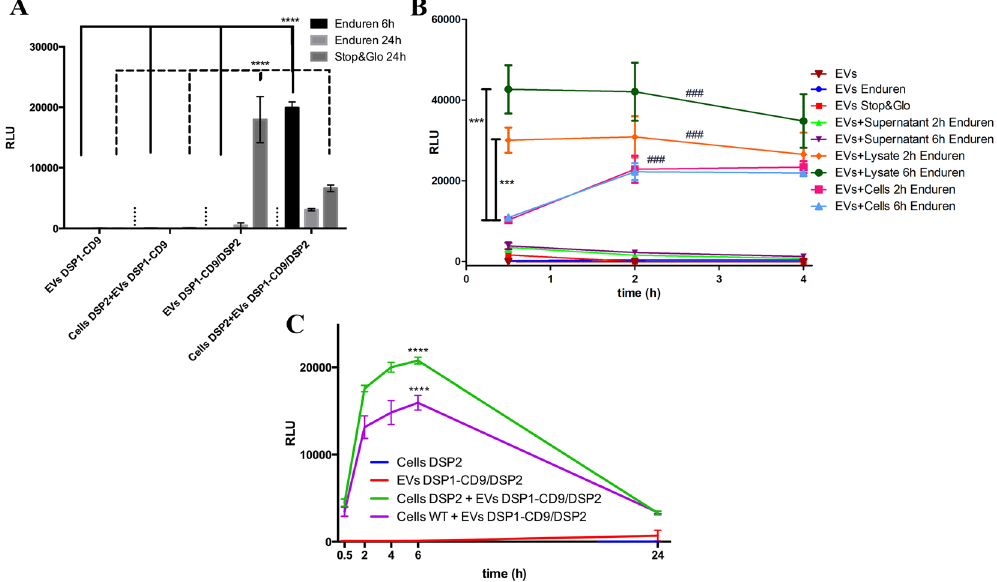
Figure 3. EVs uptake assay. ( A) DSP2-expressing target cells were preloaded with Enduren and incubated with DSP1-CD9 or DSP1-CD9/DSP2 EVs to be measured either at 6 or 24 h. Alternatively, DSP2-expressing target cells were incubated with EVs for 24 h, lysed and measured after Stop&Glo Renilla luciferase substrate addition. Signal of isolated DSP1-CD9 or DSP1-CD9/DSP2 EVs is also shown. Statistics: Statistics: **** . Two way Anova, Tukey’s multiple comparison test. n = 4. (B) DSP1-CD9/DSP2 EVs were incubated with supernatants or with mechanical obtained lysates from SUM159 WT cells preloaded with Enduren during 2 or 6 hours. EVs also were added to alive cells preloaded with Enduren at 2 or 6 hours. Controls of EVs incubated with Enduren or Stop&Glo reagent without EVs lysis are also shown. Luminescence signal from EVs with the different reagents and conditions at shown time points of incubation are depicted. Statistics: *** comparisons between EVs in the presence of cell lysates or alive cells at 0.5 hours; ### compared to EVs in the presence of cell supernatants and controls. Two way Anova, Tukey’s multiple comparison test. n = 3 (C) EV uptake kinetics using DSP2 or untransduced (WT) as target cells, pre-loaded with Enduren and incubated with DSP1-CD9/DSP2 EVs. Signal of either cells or EVs alone are also depicted. Statistics: **** compared to negative controls. Two way Anova, Tukey’s multiple comparison test. n =